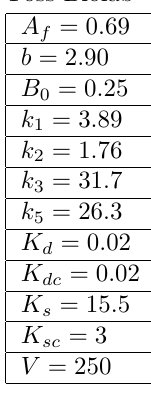
Table 11: Parameters in Hill’s model adapted to AD reactor at Foss